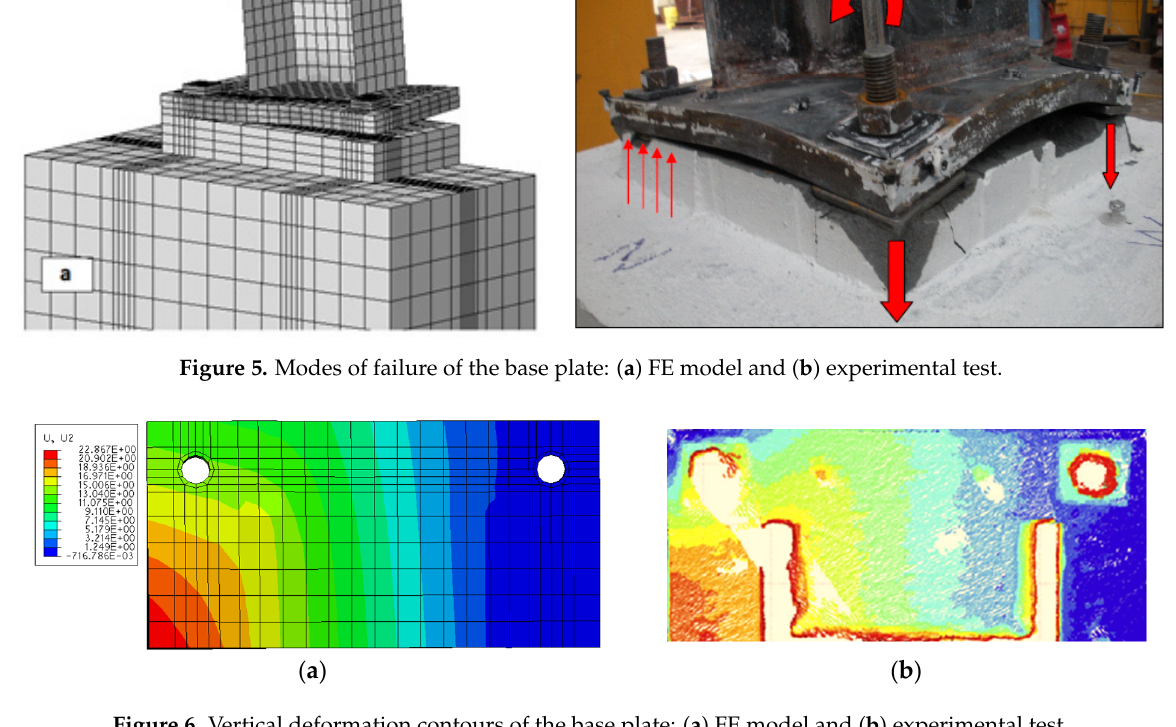
Figure 6. Vertical deformation contours of the base plate: ( a ) FE model and ( b ) experimental test.